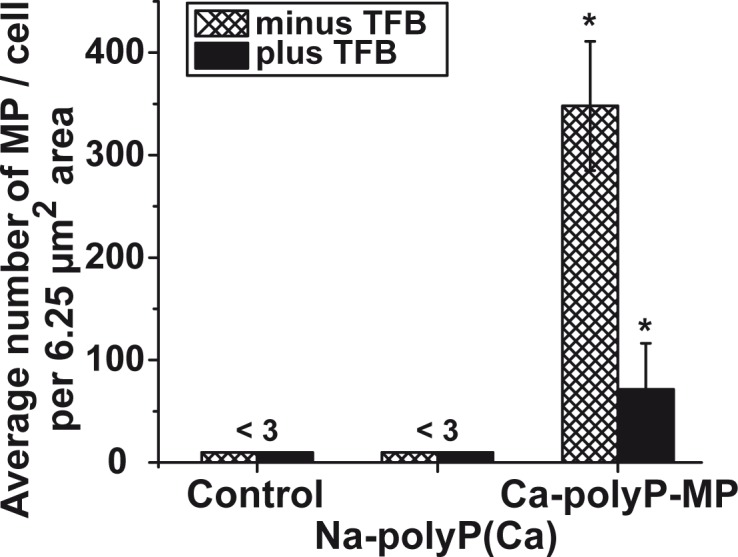
Semiquantitative analysis of the number of particles taken up by SaOS-2 cells.As described under “Material and Methods” the cells were incubated with 30 μg/mL of “Na-polyP[Ca2+]” or “Ca-polyP-MP”; the controls remained without polyP. After incubation, the cells were sliced and inspected by TEM. The number of particles per defined cell area (2.5 μm x 2.5 μm; 6.25 μm2) after sectioning was determined; mean values ± SE; * p < 0.05; n = 50.